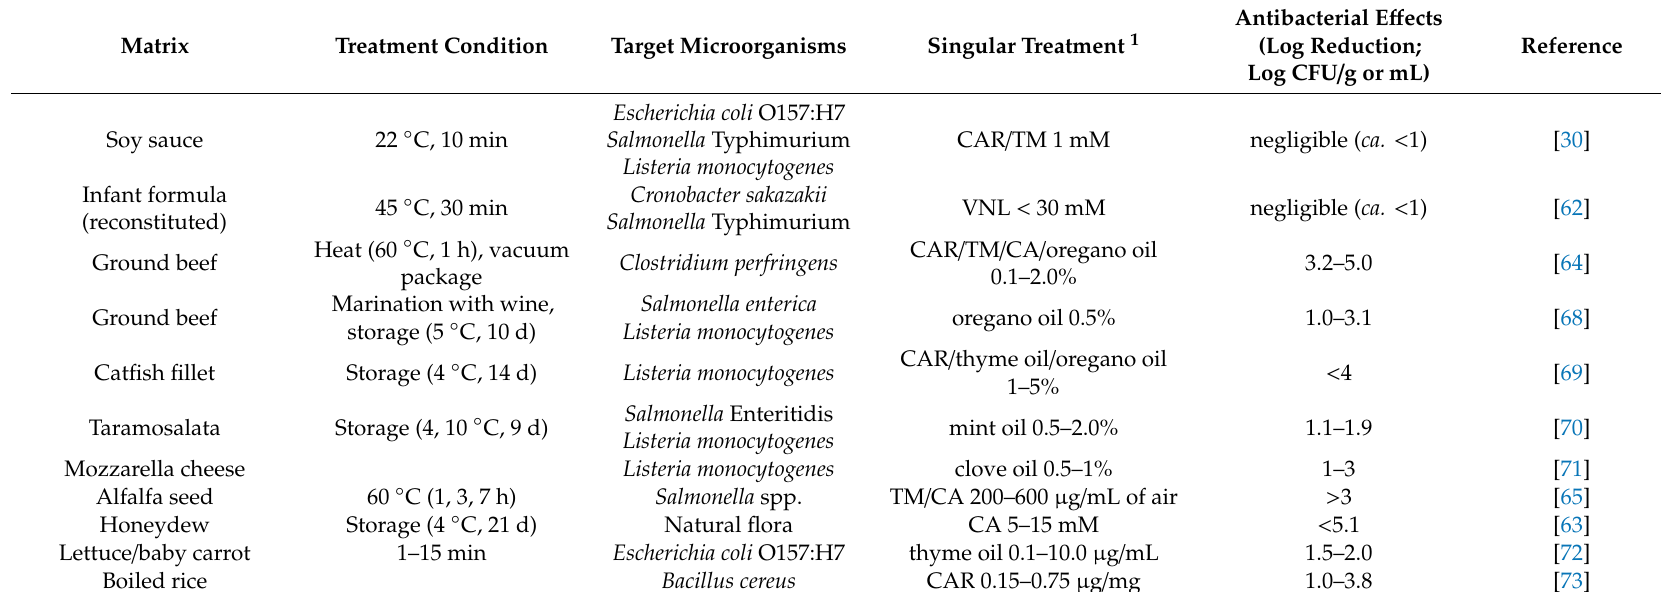
Table 2. Antimicrobial e ffi cacy of singular treatment of essential oils in